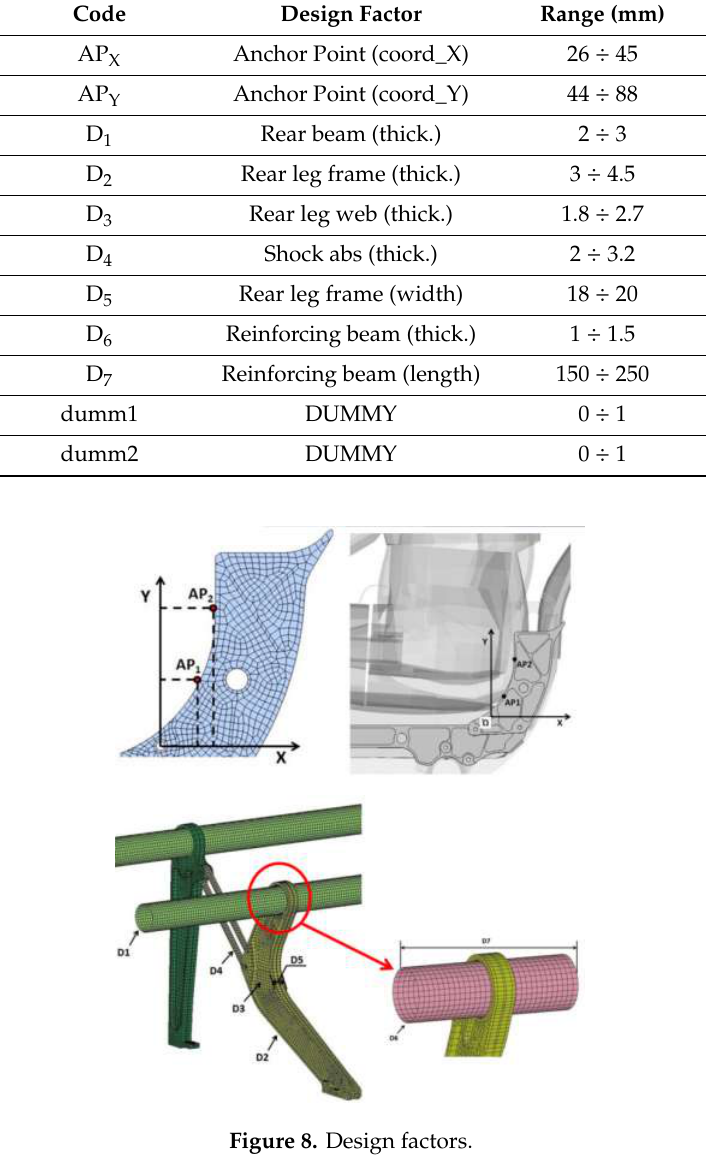
Figure 9. Results of the second round of numerical experiments. Figure 9 shows the head displacements in two selected frames for both the preliminary and modified FE models, respectively. According to Figure 10, the red displayed head trajectory is representative of the head–bulkhead impact in the preliminary FE model, whilst the green one indicates the lack of contact in the new model. It must be noticed that the developed FE model is very time-demanding, requiring about 20 h for each run. This suggests the development of a new model, able to take advantages from both the FE and the Multibody (MB) (less time-consuming) approaches. In a previous paper, [8], the authors demonstrated that computational costs are reduced by up to 2 h using a hybrid FE-MB model, which simultaneously implements MB models, for system components whose deformations do not influence the dynamic system responses and for which only kinematic aspects must be investigated (e.g., anthropomorphic dummies), and FE models for the other system components.